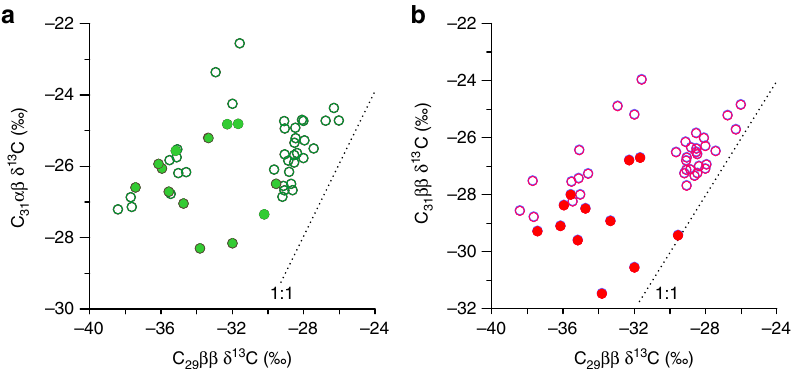
Fig. 6 Cross-plots between the carbon isotope ratios of hopane homologues. a C 29 ββ vs. C 31 αβ hopane. b C 29 ββ vs C 31 ββ hopane. In each panel, samples from the glacial period are labeled as solid circles, while samples from the Holocene are labeled as open